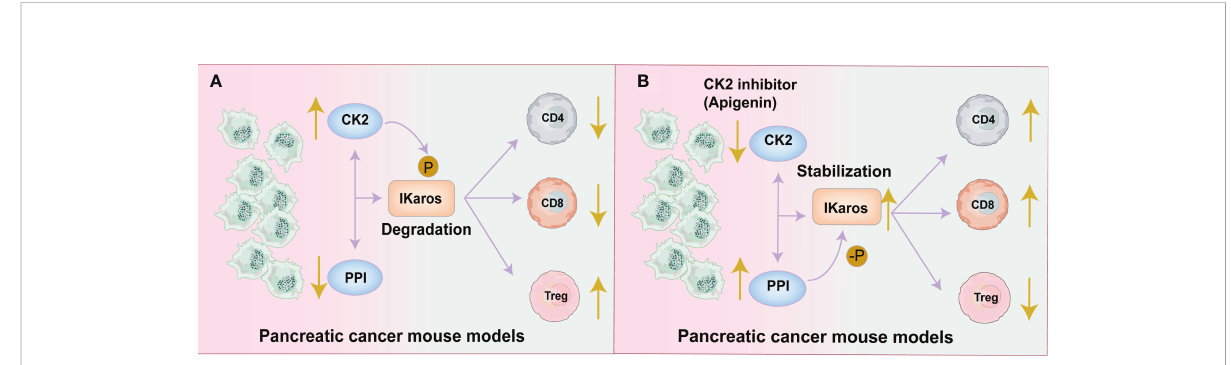
FIGURE 2 CK2 activity decreases the effector CD4 + and CD8 + T cells and increases Tregs by regulating the Ikaros signal. (A) Pancreatic Tumor Microenvironment without Apigenin (API): CK2 activity phosphorylates the Ikaros signal and promotes its degradation, leading to the downregulation of Ikaros expression. The reduction in Ikaros expression causes an increase in Tregs and a decrease of effector CD8 + T and CD4 + T cells. This leads to a decreased antitumor effect. (B) Pancreatic Tumor Microenvironment with API: API targets and reduces the activity of CK2 and restores the expression of Ikaros, increasing the effector CD8 + T and CD4 + cells while reducing Tregs to promote antitumor